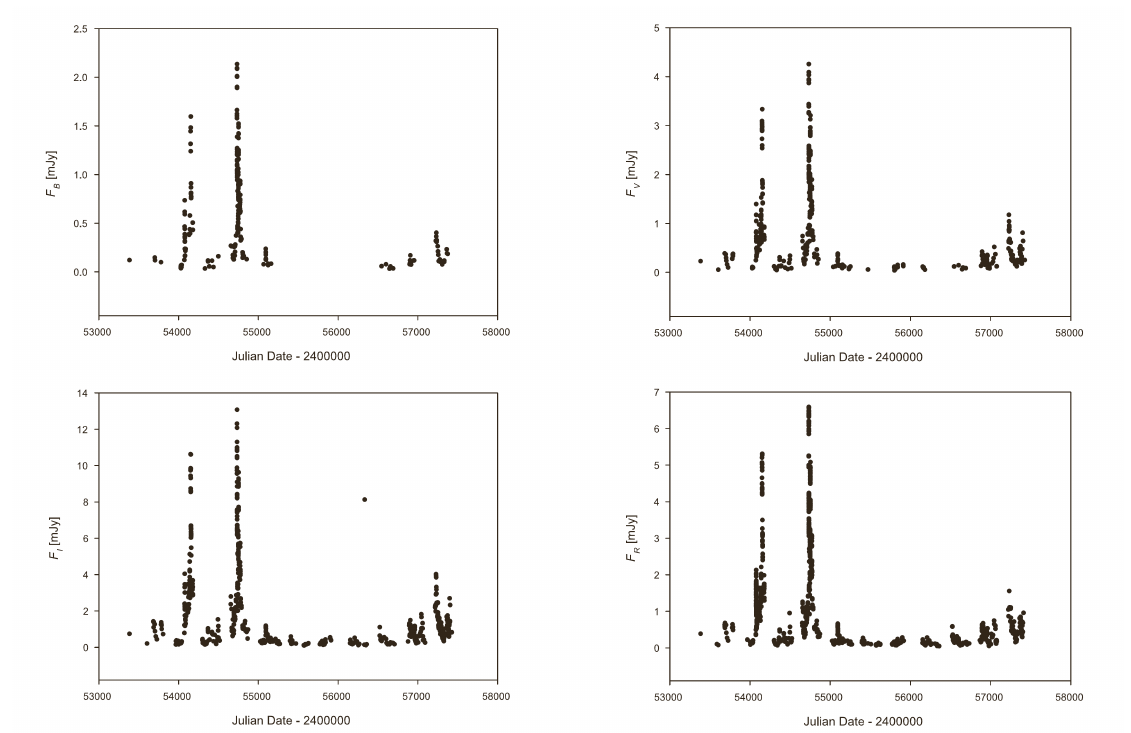
Figure 3. Flux diagrams in filters B , V , R c , I c for